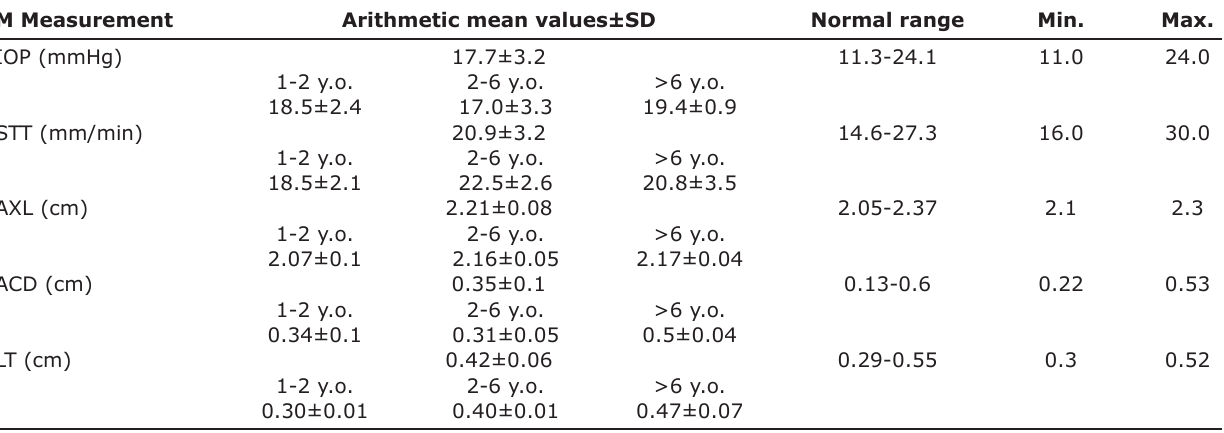
Table-1: Arithmetic values of STT, IOP AXL, ACD, and LT in Latvian Hunting dog. M